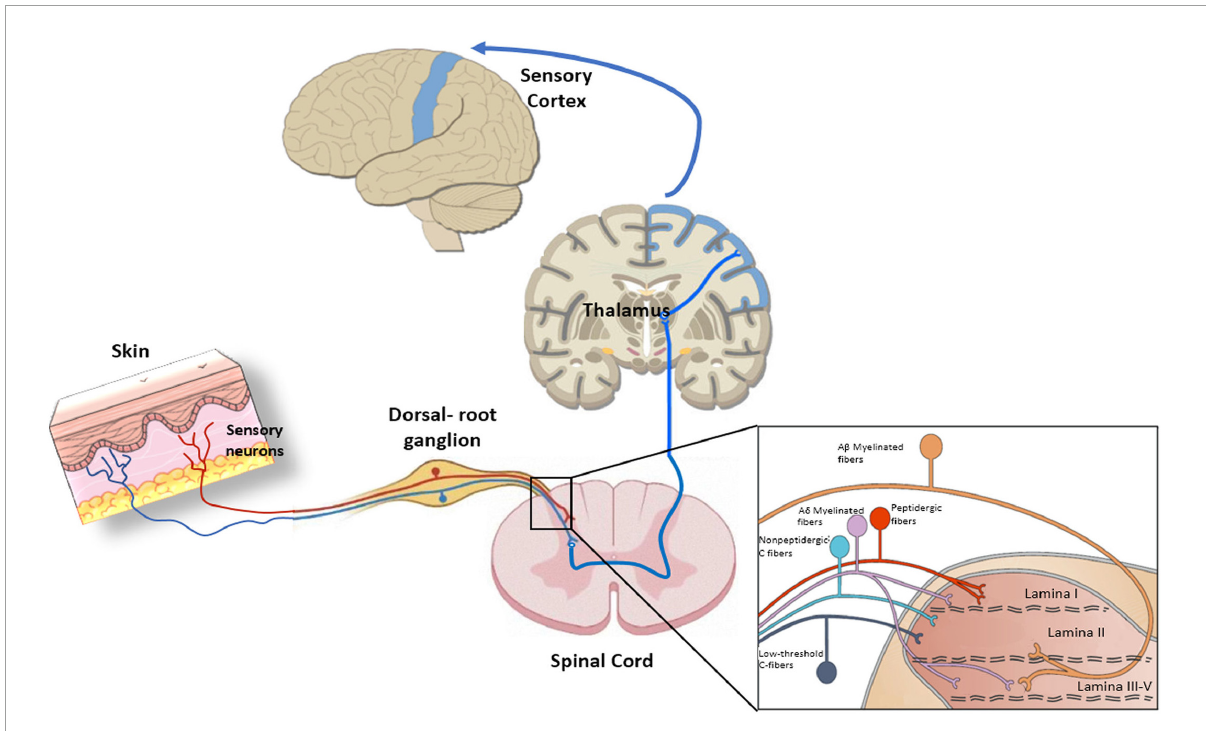
FIGURE3 Peripheral nociception, Primary sensory neurons present a bifurcated axon with one branch innervating peripheral tissues and the other one reaching the central nervous system (CNS). The pathway starts with sensory neurons that synapse in the dorsal horn of the spinal cord. Next, neurons extend from the dorsal horn and decussate, or cross over to the other side of the spinal cord, before traveling up the spinal cord, through the brainstem, and to the thalamus. There, thalamic neurons integrate peripheral nociceptive information through projections to the somatosensory cortex, which processes the information. The insert indicates the organization of primary afferent fibers projecting to spinal cord dorsal horn. Nociceptive fibers terminate mainly in superficial dorsal horn (laminae I–II), while tactile afferents [A β and LT (low threshold) A δ ] project mainly to deep dorsal horn (laminae III–V). Nociceptive projection neurons are located in lamina I, while wide dynamic range neurons, activated by both tactile and nociceptive stimuli, are localized in lamina